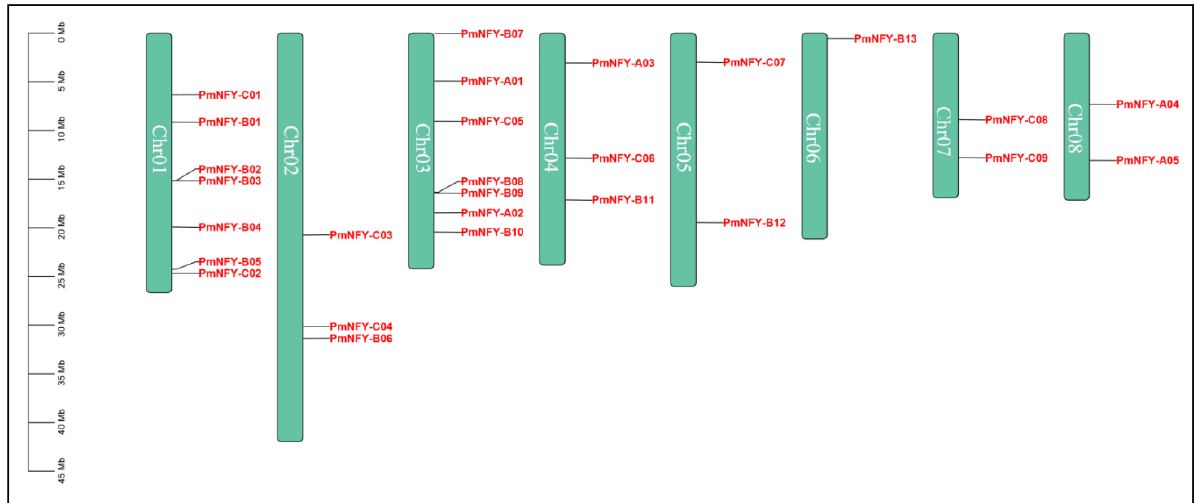
Figure 1. Distribution of PmNF-Y genes among 8 chromosomes. The scale on the left represents the length of the chromosome. The chromosome numbers are on each